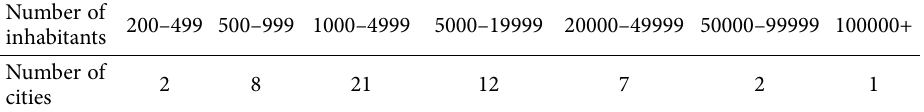
Table 2. Application of the municipal coefficient according to the municipality’s size